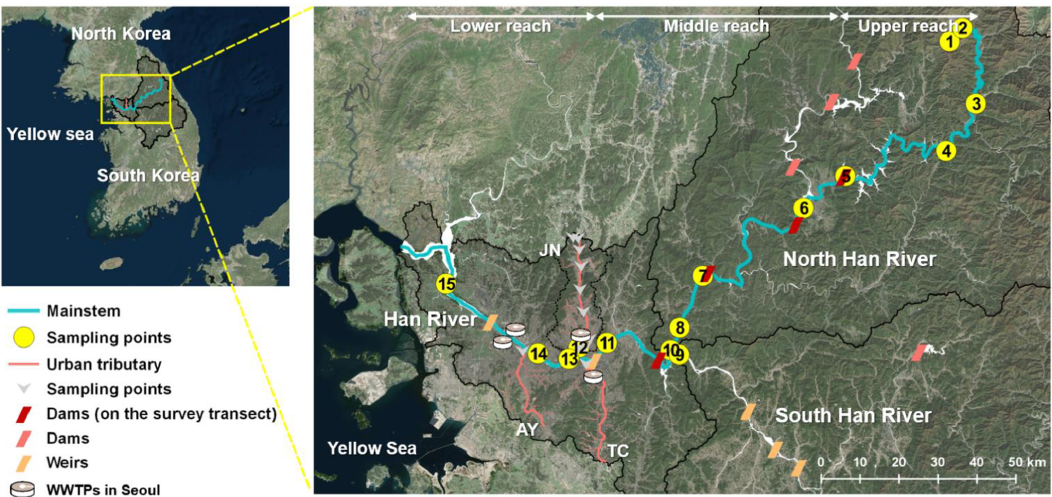
Figure 1. Study map showing sampling sites along the main stem and three urban tributaries (JN, TC, and AY) in the Han River basin, South